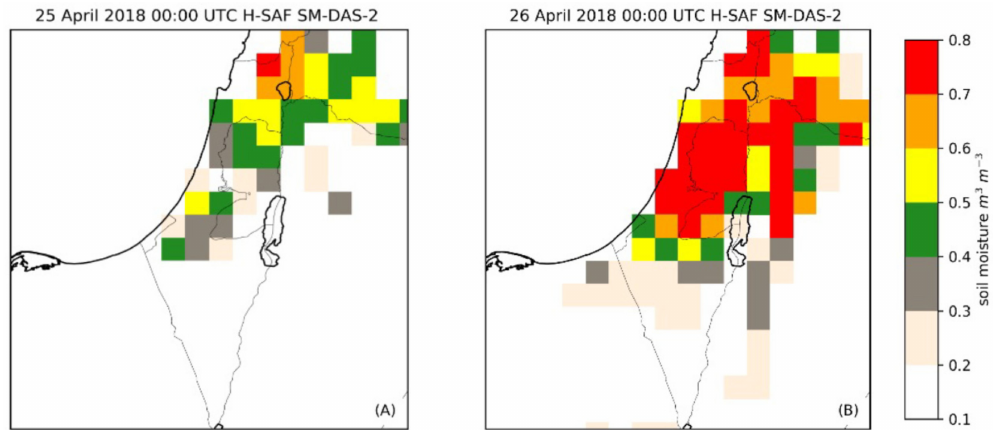
Figure 1. Advanced Scatterometer (ASCAT) derived moisture index within the upper soil layer with thickness of 0.07 m, at the beginning of ( A ) 25 April 2018 and ( B ) 26 April